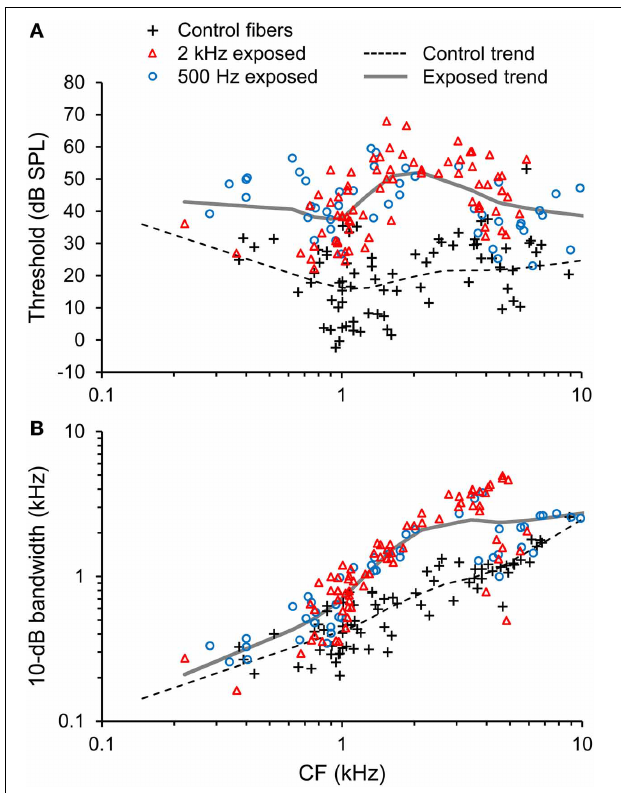
FIGURE 3 | Pattern of noise-induced sensorineural hearing loss (SNHL). (A) Tuning curve thresholds and (B) and 10-dB bandwidth plotted as a function of CF in normal-hearing control fibers and fibers overexposed to noise. Trend lines are based on local regression analyses. Noise overexposure was associated with threshold elevation and increased tuning bandwidth.